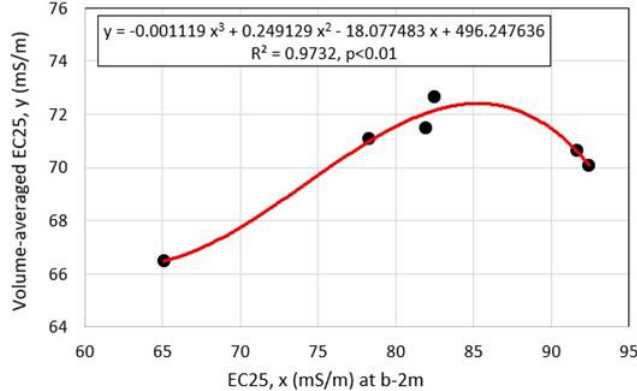
Figure 18. Relationship between the volume-averaged EC25 from the six profiles and the EC25 from the EC logger at 2 m above the bottom of site MD.